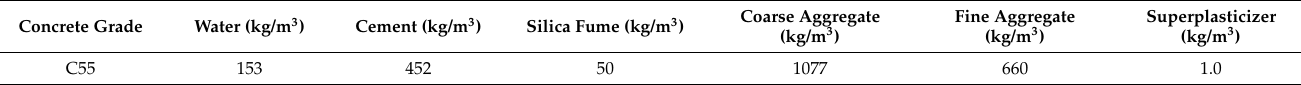
Table 1. Mix proportions of the OCS.